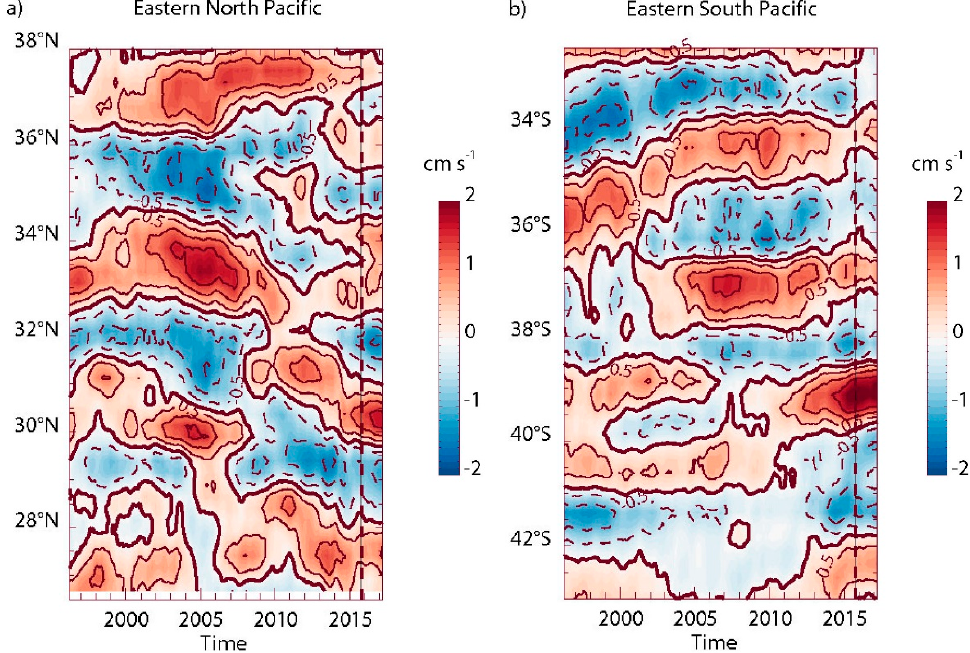
Figure 13. Time evolution of spatially high-pass filtered SSALTO/DUACS U g (cm s − 1 ) over the full available altimetric record (1 January 1993–3 June 2020) in the ( a ) ENP and ( b ) ESP, averaged quasi-zonally within the offshore tilted solid boxes in Figures 2g and 3g. A moving average of width equal to that of the study period (2 July 2012–31 December 2018 ~6.5 years) was applied to the time series of cross-striation profiles. The dashed vertical line near the end of the time series marks the data over the study period on both panels, corresponding to the U g profiles shown in Figure 6a,d (see also, Figures S3c and S6c).